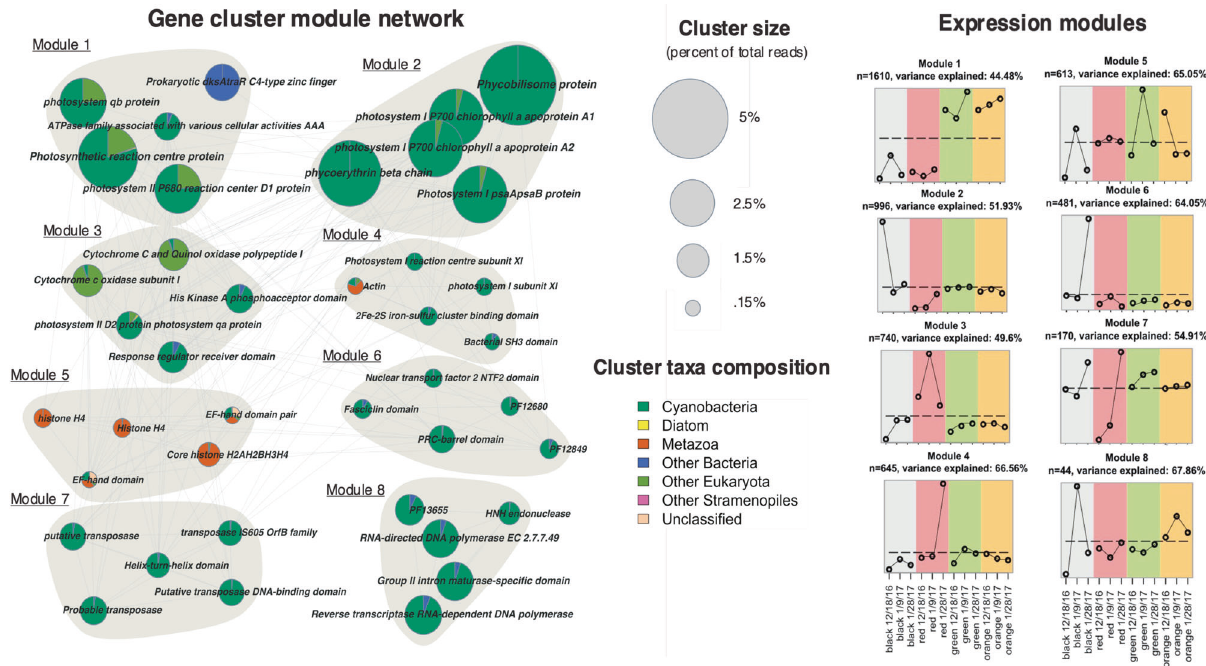
Fig. 6 Visualization of networks of co-expression modules as determined by WGCNA. Pie charts represent highly abundant functional clusters of ORFS colored by taxonomic contribution and sized by percent of total reads ( left ). Co-expression patterns of modules colored by mat type ( right ). Subtitle describes number (n) of ORFs in each module as well as percentage of variance explained by each module ’ s expression pro fi